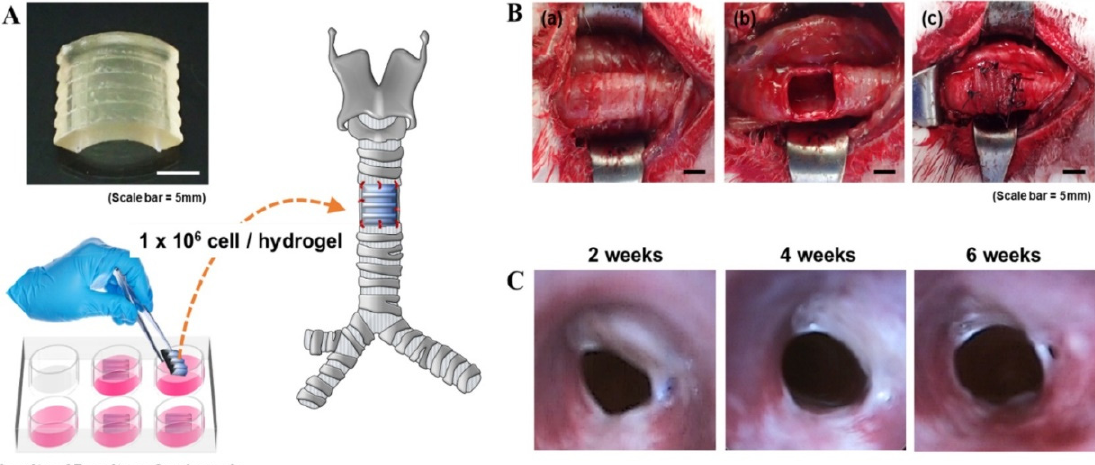
Figure 5. Schematic presentation of chondrocyte-encapsulated SF-GMA hydrogel implantation and endoscopic evaluation of rabbit trachea 6 weeks post-implantation. ( A ) Artificial trachea was fabricated using a DLP printer with chondrocyte-encapsulated SF-GMA and cultivated for 1 week in vitro. ( B ) ( a , b ) After surgery and elimination of the incised portion of the trachea, (c) fabricated trachea was transplanted. Scale bars present 5 mm. ( C ) Endoscopy was performed after 2, 4, and 6 weeks from trachea implantation. SF-GMA hydrogel exhibited the inner length progressively increased after implantation, and surrounding tissues developed in the operating area after 6 weeks of transplantation. Adapted from [75] with permission from Elsevier.